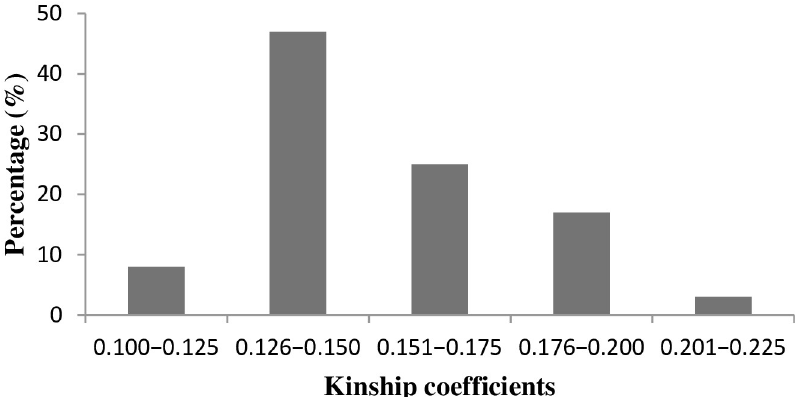
Fig 2. Distribution of pair-wise relative kinship for thirty inbred lines and three testers with varying level of resistant to S . hermonthica calculated using 6081 DArTseq SNPs.